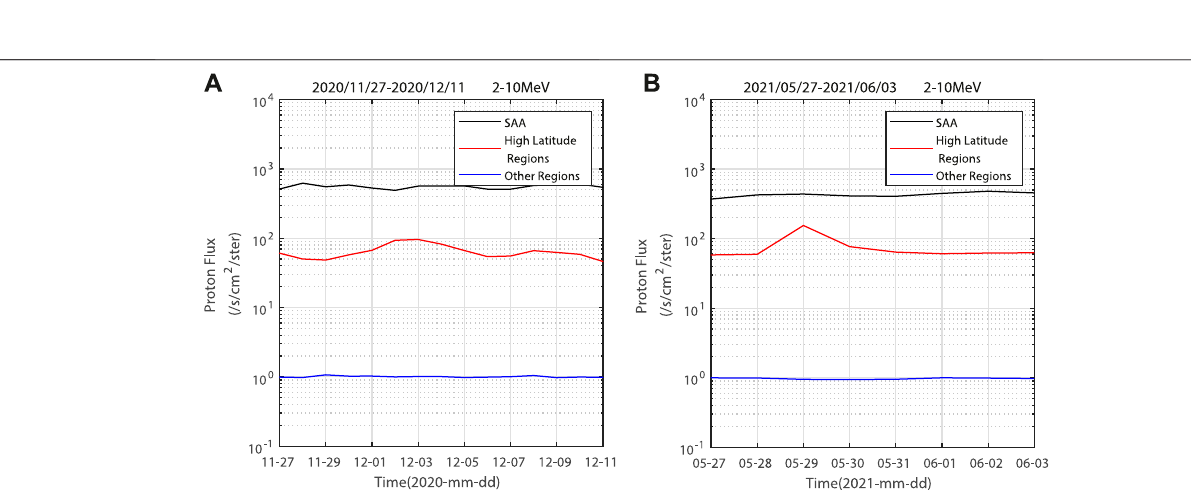
Frontiers in Earth Science |